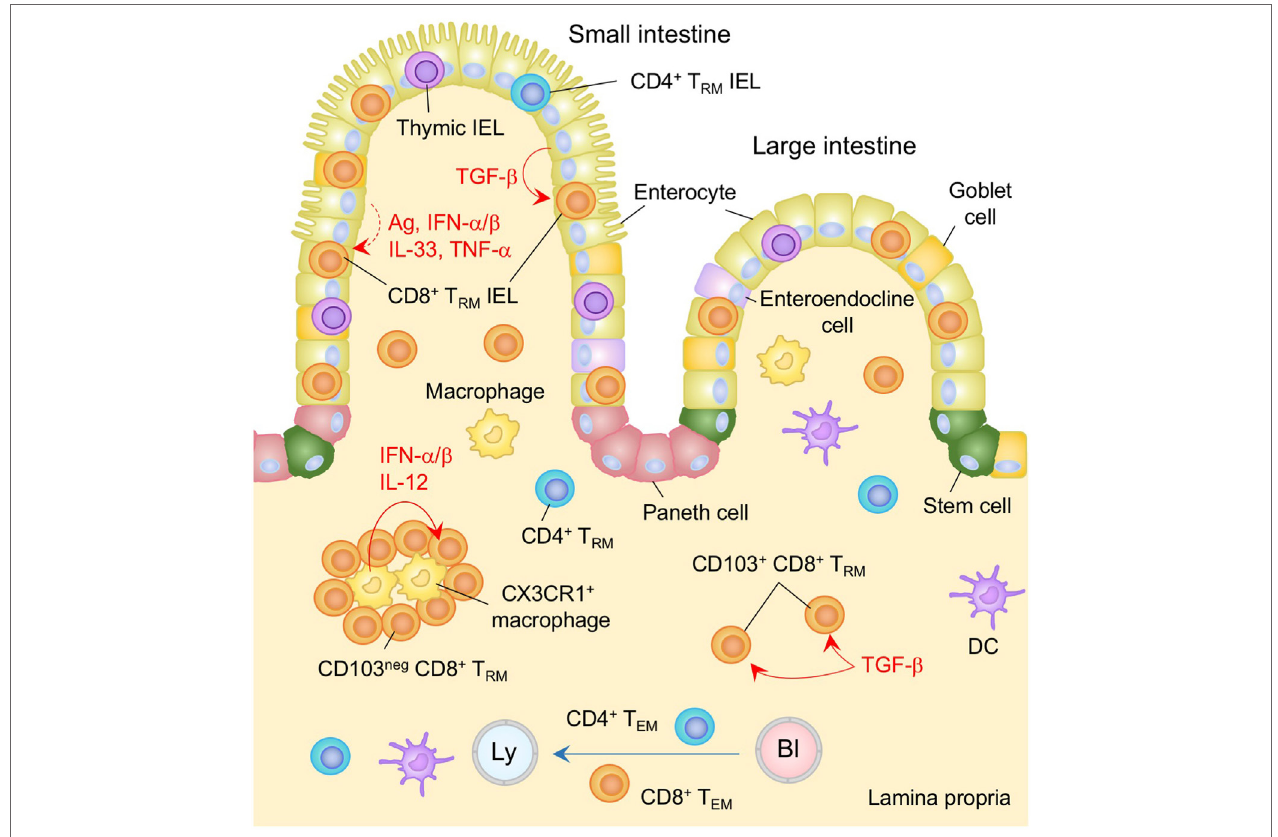
FiGURe 2 | T RM niches in the in the intestine. Large numbers of CD8 + T RM cells and few numbers of CD4 + T RM cells are present in the intestinal intraepithelial lymphocyte (IEL) compartment. TGF- β is constitutively available in the intestinal epithelium and promotes the generation of T RM cells in this compartment by upregulating CD103 as well as Runx3. Either cognate antigen or inflammatory cytokines is required for upregulation of CD69 on epithelial T RM cells. Both TGF- β -dependent (CD103 + ) and independent (CD103 − ) populations of CD8 + T RM cells present in the lamina propria (LP). The latter form cluster with CX3CR1 + macrophages. Interferon (IFN)- α / β and IL-12 secreted by macrophages control the size of the cluster. T EM cells are passing through the LP. Orange and blue cells indicate CD8 + and CD4 + T RM cells, respectively, unless otherwise stated. Red lines indicate the representative niche factors that influence the maintenance of T RM cells. A blue line indicates the migratory route. A dashed line indicates potential impact of niche factors. Abbreviations: Ly, lymph vessel; Bl, blood vessel; Ag, antigen; neg, negative; T RM , tissue-resident memory T cells; T EM , effector memory T